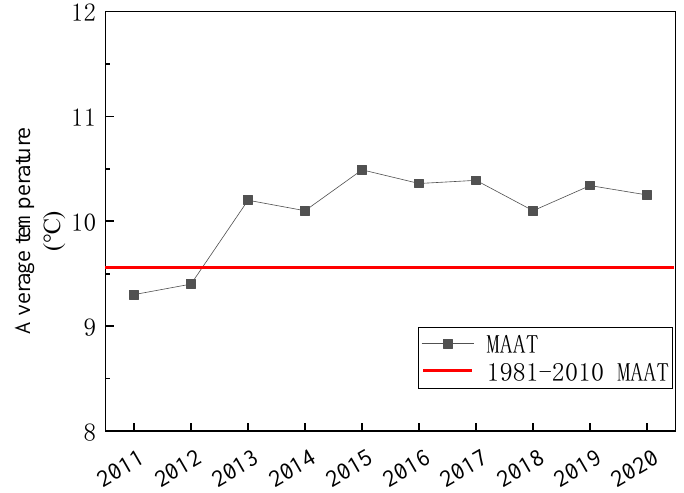
Figure 11. National mean annual average temperature changes over the years.